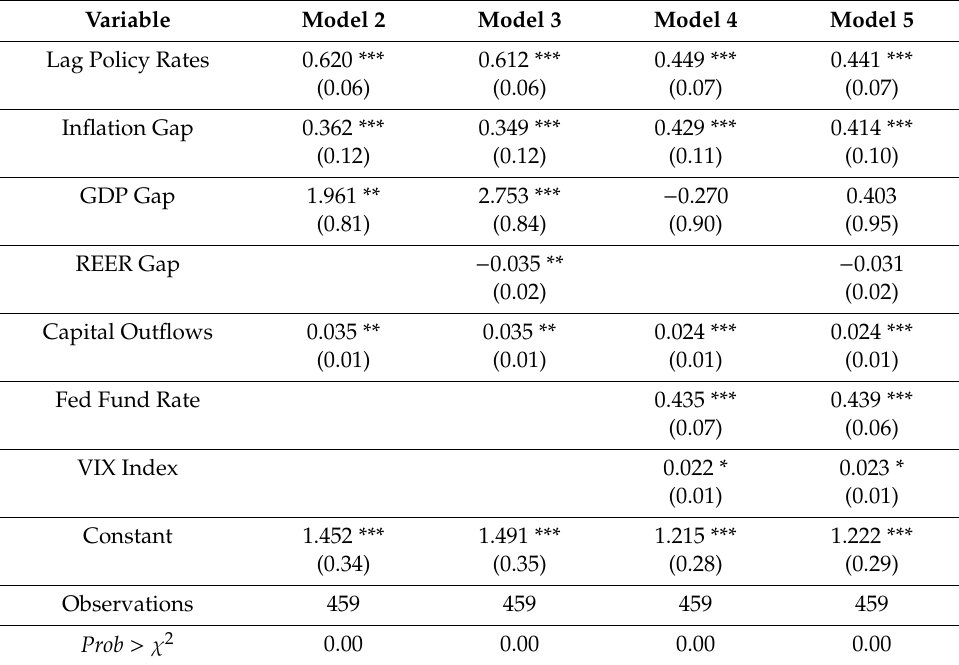
Table 6. The Augmented Taylor Rule with Capital Outflows.